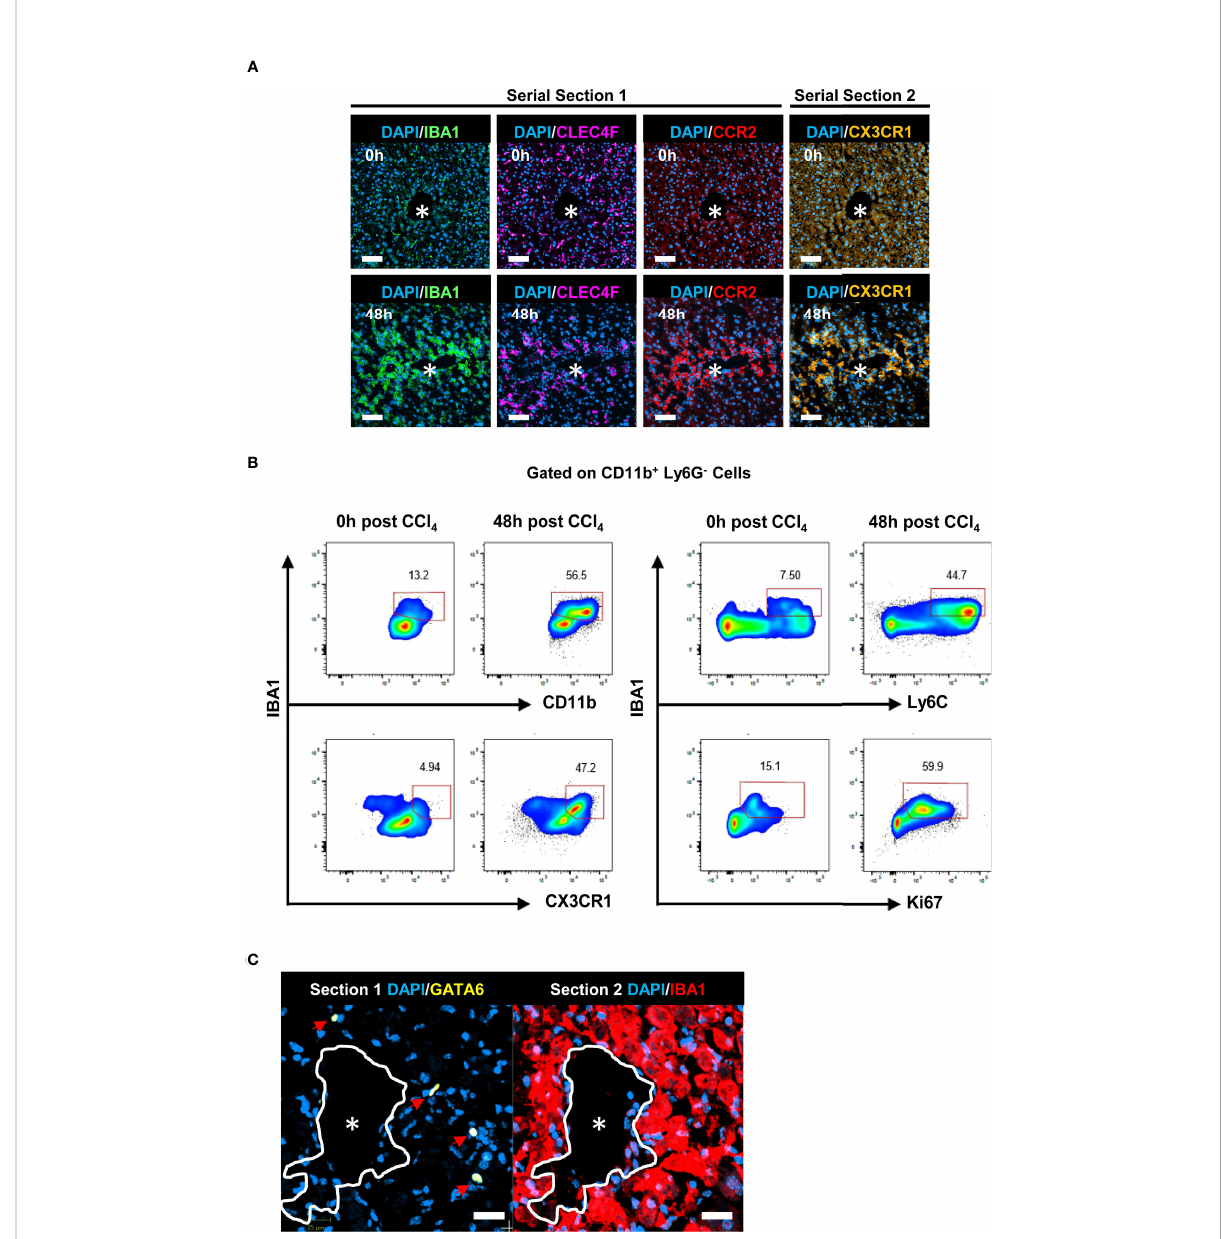
FIGURE 6 IBA1 + CLEC4F - macrophages exhibit phenotypic markers of MoMFs. (A) Representative mIF images of IBA1 (green), CLEC4F (magenta) and the monocytic markers CCR2 (red), CX3CR1 (orange) and DAPI (blue) around CVs at 0 h vs. 48 h post-CCl 4 , scale bar= 75 m m. IBA1, CLEC4F and CCR2 were multiplexed on the same section (section 1), CX3CR1 was imaged in the contiguous section (section 2), the *indicates CV. (B) Representative pseudocolor fl ow cytometry plots of intrahepatic IBA1 + myeloid cells at 0 h vs. 48 h post-CCl 4 . Cells were gated on CD11b + Ly6G - cells. The numbers next to the plots represent frequencies in this gate. (C) Representative digital alignment of IF images from serial sections showing on the left GATA6 (yellow), as a marker of peritoneal macrophages, and on the right IBA1 (red). The demarcation (white line) is to facilitate the visual merge. DAPI nuclei are in blue, scale bar =25 m m. The perimeter of the CV is delineated in white. N=4 mice per